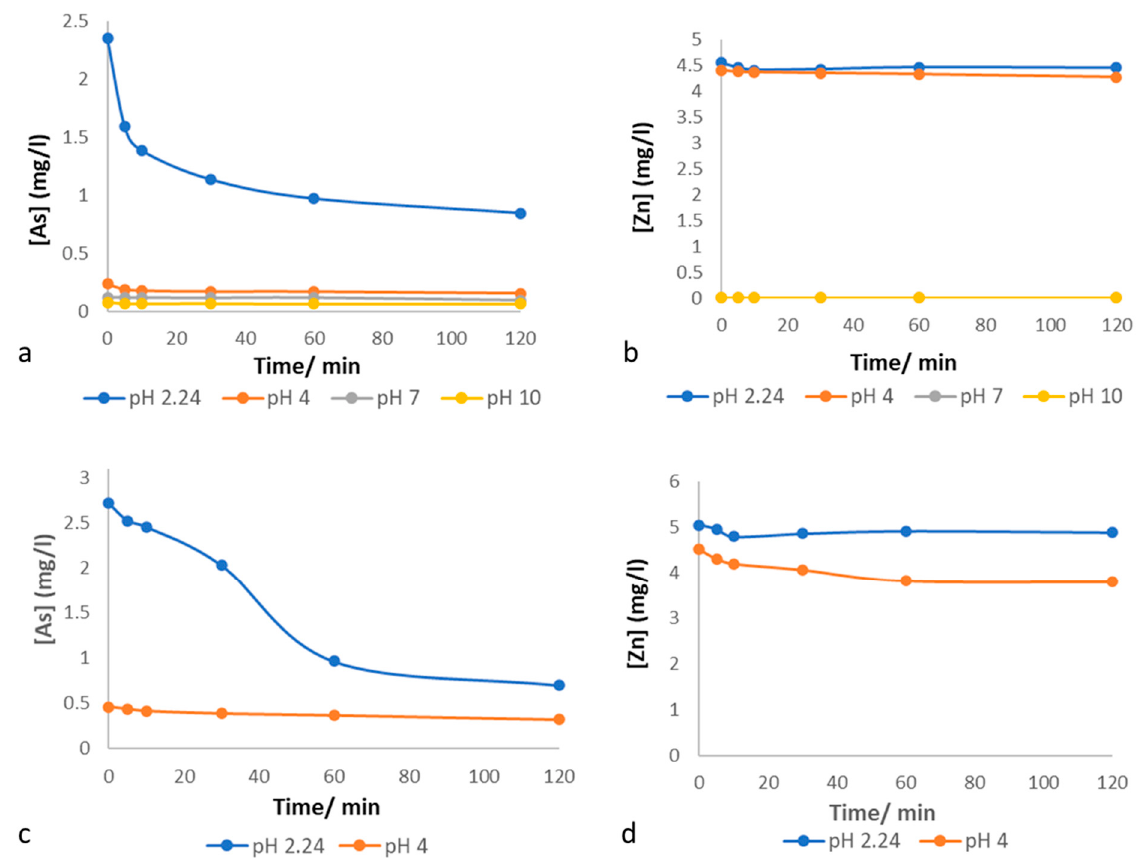
Figure 6. Effect of initial pH value on the pollutant adsorption from Caracarani River water using the biogenic iron precipitates ( a ) arsenic and ( b ) zinc; and using the iron precipitates/alginate beads ( c ) arsenic and ( d ) zinc. Adsorbent concentration: 1 g/L.